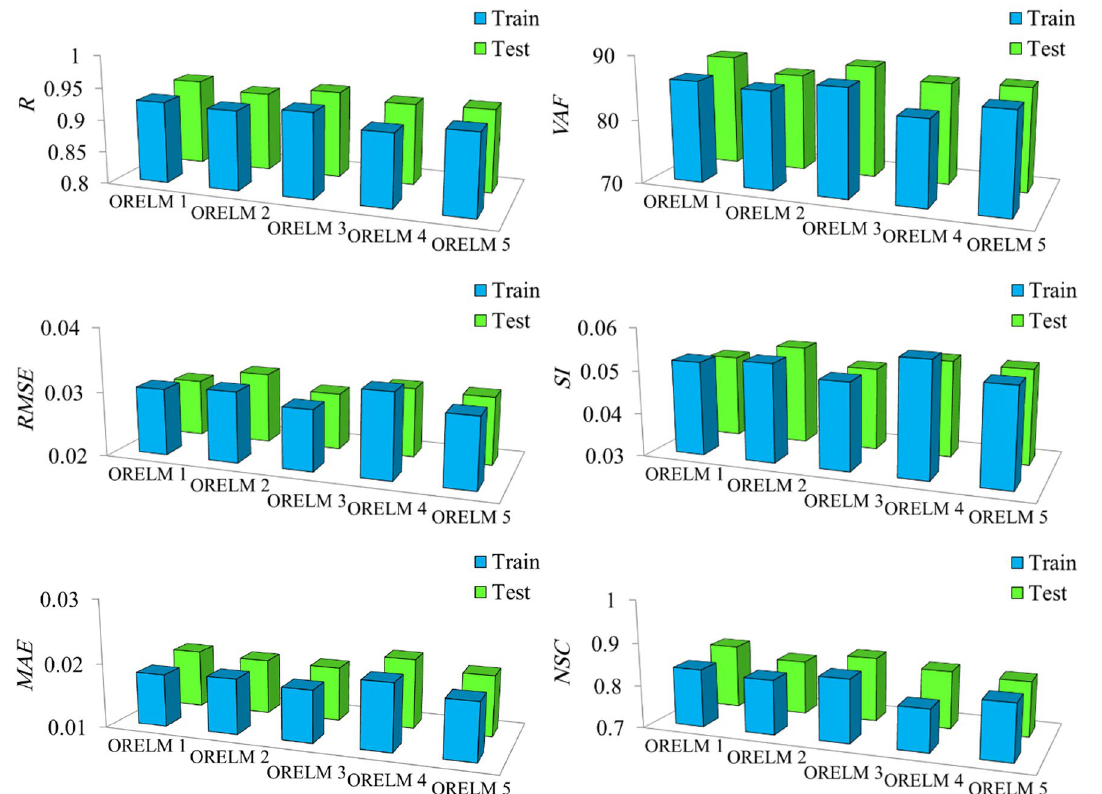
Fig. 8 Outcomes of statistical indices computed for ORELM models in both